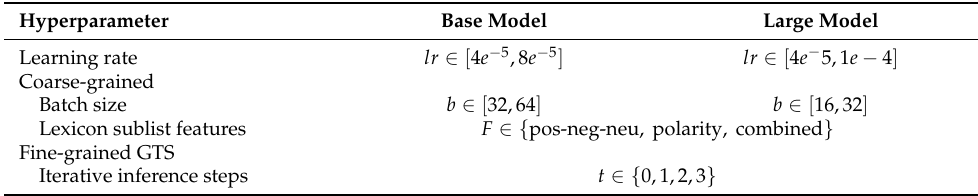
Table A1. Hyperparameter